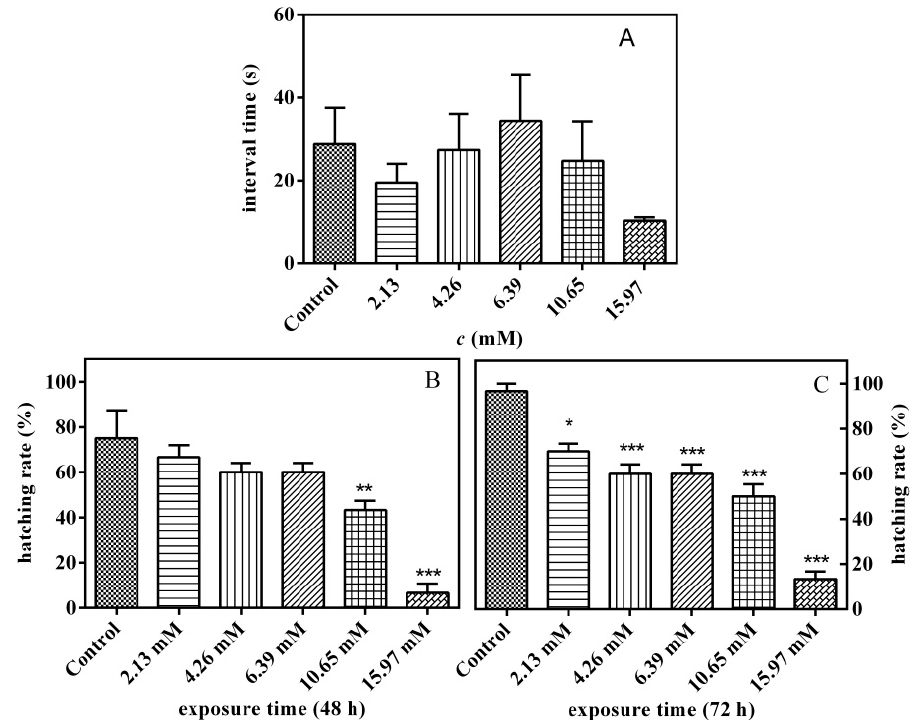
Figure 5. Effects of PFLX on the interval time (s) between two connected spontaneous movements of the embryos in the chorion for 24 h exposure. ( A ) Effects of PFLX exposure on hatching of embryos, ( B ): 48 h, ( C ): 72 h. The asterisk symbols (*) denote no significantly different results compared to control group, * p < 0.05, ** p < 0.01, *** p < 0.001. The effect of PFLX exposure on embryo hatchability was investigated. After 48 h of exposure, embryos in the blank control group and all concentration groups began to hatch (Figure 5B). The PFXC exposure groups all have inhibitory effects on hatching and show a typical dose–effect relationship. When the PFXC concentration increases to 10.65 mM, the embryo hatching rate is 43.2%, which is significantly lower than that of the blank control group (75.0%) ( p < 0.01). After 72 h of exposure, most of the embryos had hatched out of the membrane, and all exposed groups of PFXC had a significant inhibitory effect on embryo hatchability ( p < 0.05) (Figure 5C). The hatching rate was 60% under 4.26 mM PFLX exposure, which is much lower than that of the blank control group (96.7%) ( p < 0.001). Therefore, the hatching rate decreases with the increase of PFLX concentration. When the concentration of PFLX increased to 15.97 mM, the hatching rate was only